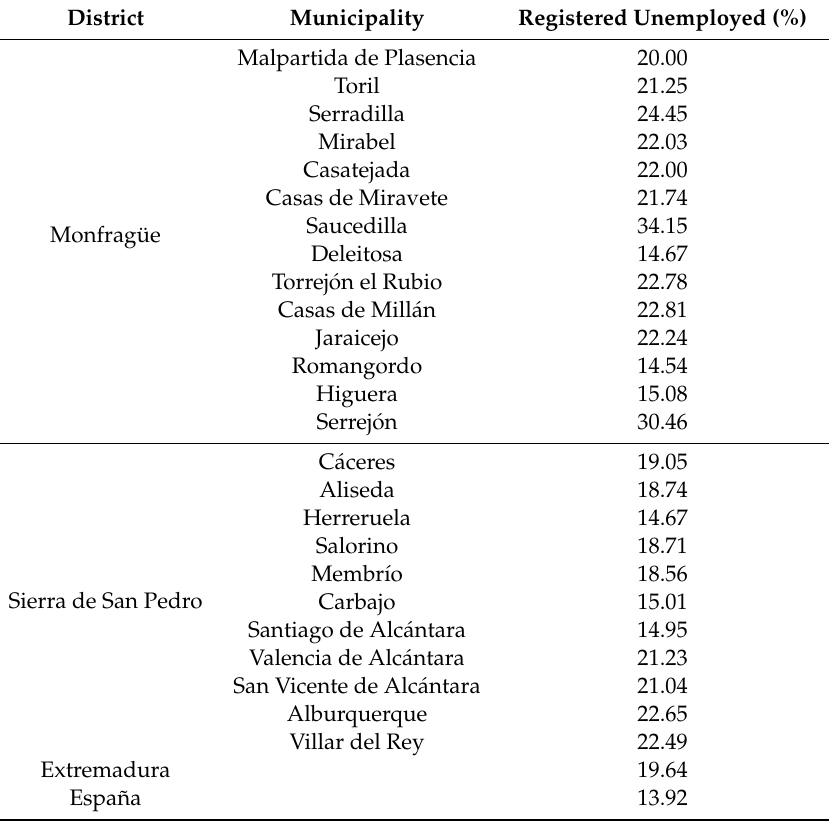
Table 4. Registered unemployed rates by